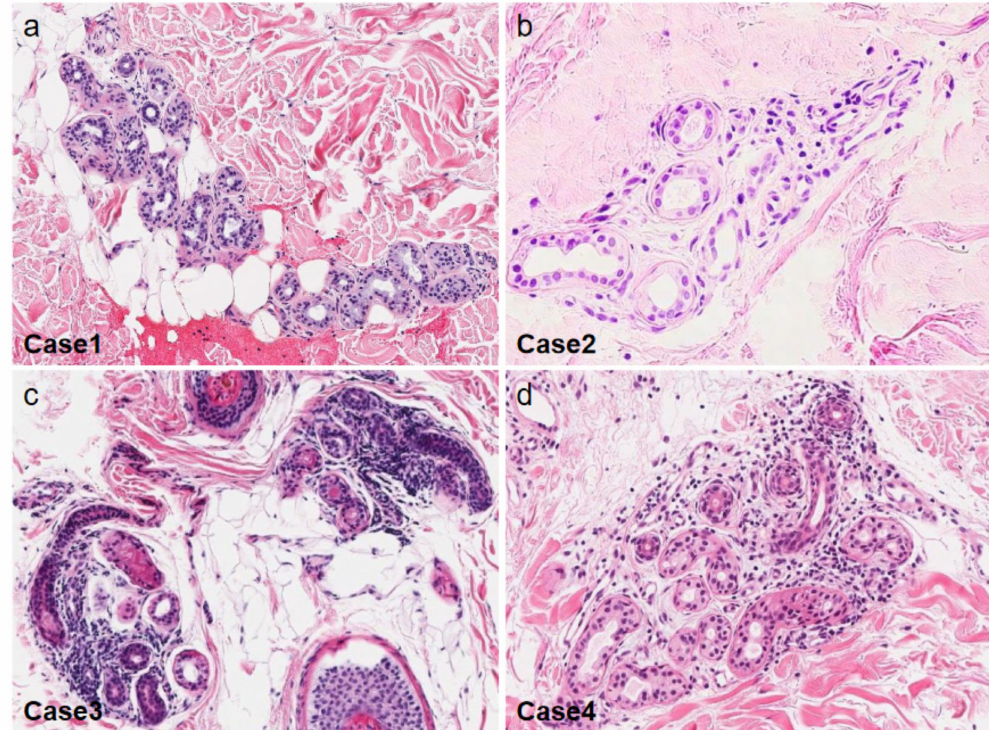
Figure 3. Skin histopathology of the anhidrotic area in our cases. Mild to moderate lymphocyte infiltration around the sweat glands is observed in Cases 1, 3, and 4 ( a , c , d, original magnification × 40, × 100 and × 100 respectively), but scarce in Case 2 ( b, original magnification × 200) (Hematoxylin-Eosin